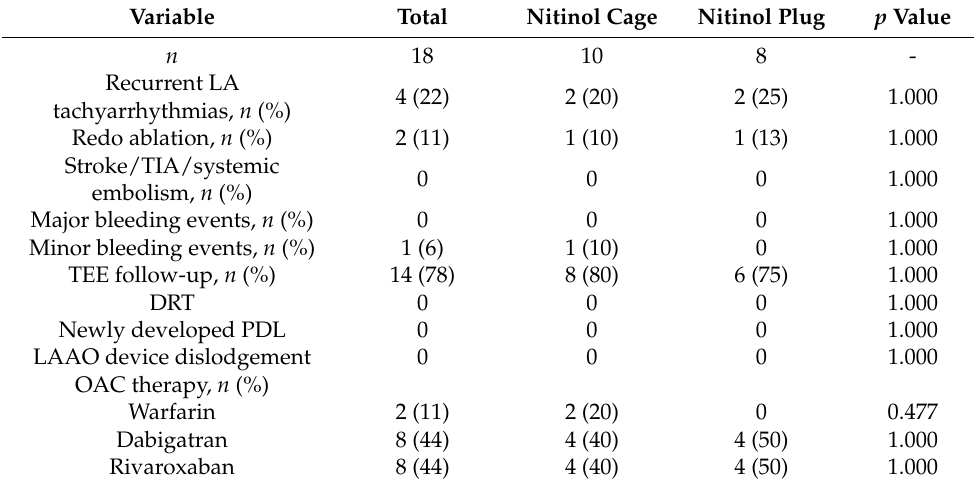
Table 3. Follow-up